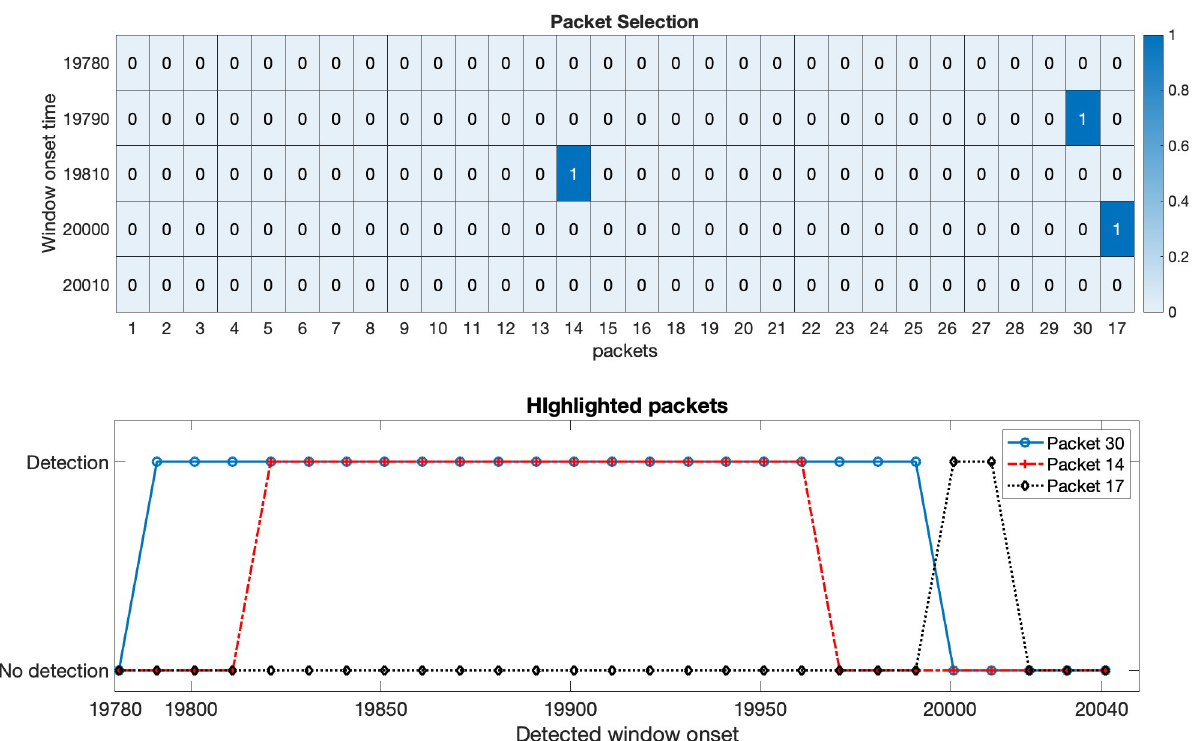
Fig 4. Packet selection. The plot on top depicts the selected packets on the fly based on the ranking of highlighted packets. Y-axis represents the window onset time in the ranked order (top to bottom). The presence of 1 indicates detection, and 0 represents no detection. The duration of highlighted packets is shown in the bottom plot, where the X-axis represents the onset of the working window.